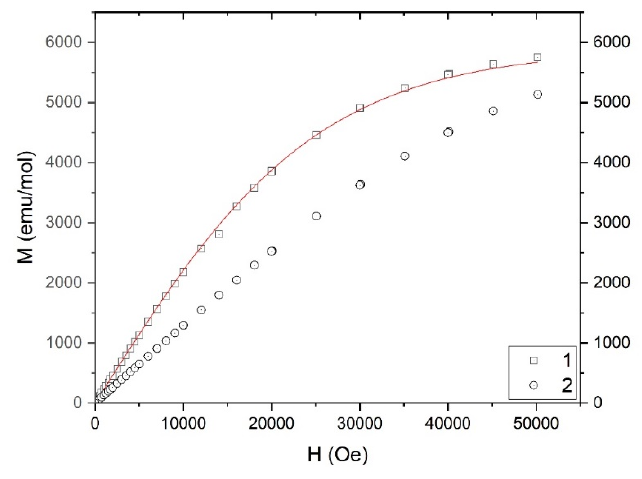
(cid:3) ) and 2 ( ). The solid line is the fit to the S = 1 (cid:35)